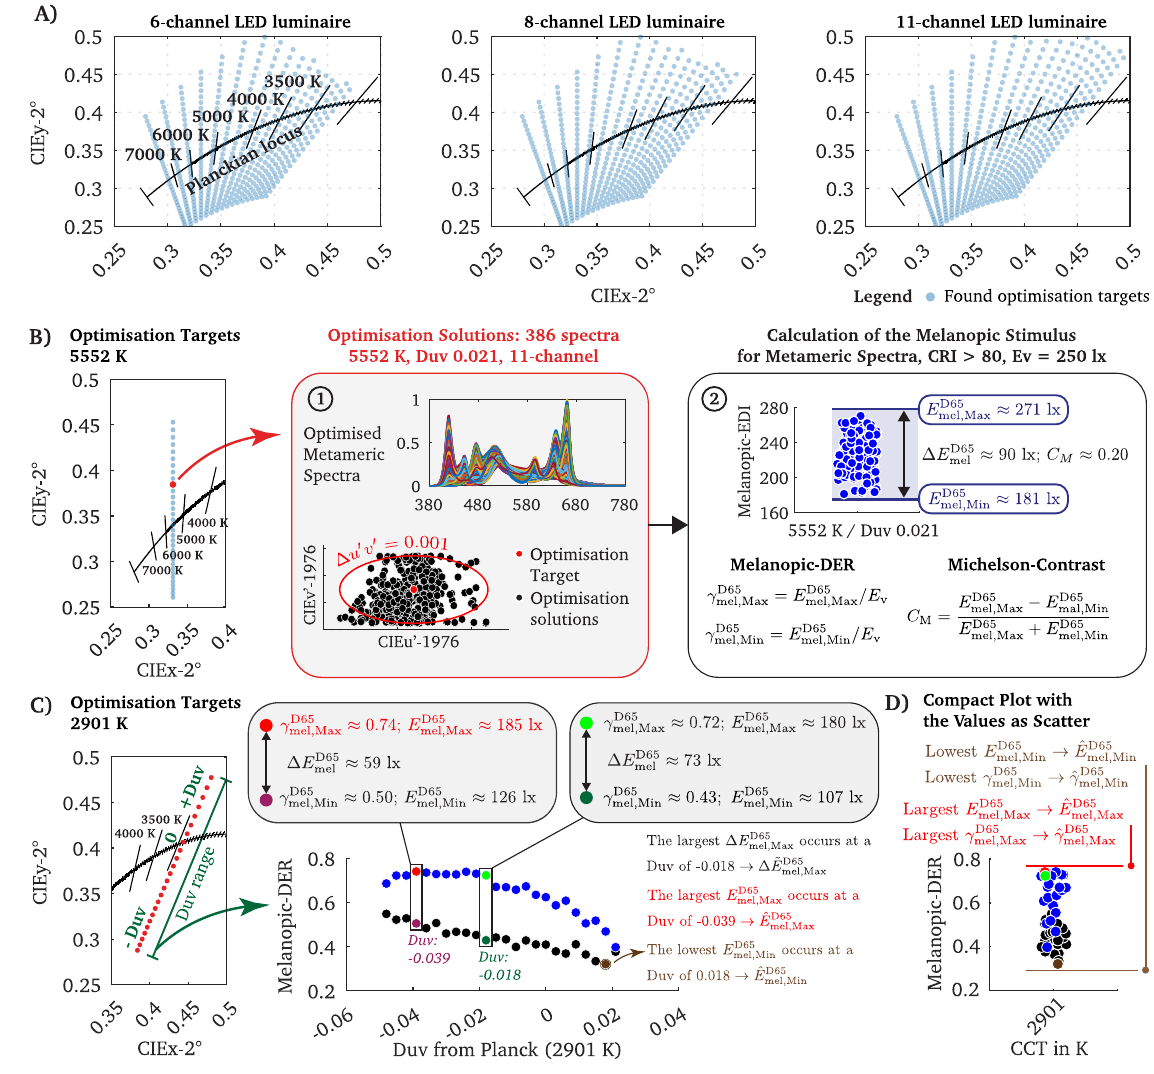
Figure 1. The chromaticity coordinates for which spectra where successfully optimised and strategies of assessing the non-visual quality of the metameric spectra. ( A ) We used a uniform grid of 561 chromaticity coordinates along the Planckian locus (2700 K to 7443 K ± Duv 0 to 0.048 with Duv-steps of 0.003) as optimisation targets for spectral optimisation. Depending on the LED luminaire’s channel configuration, the number of successfully optimised spectra per chromaticity target differs. The 6-channel LED luminaire, for example, was unable to yield spectra for chromaticity targets with higher Duv values at CCTs between 2700 and 3000 K. The blue scatter points in the CIExy-2° colour space highlight the chromaticity coordinates for which metameric spectra were successfully optimised. ( B ) For each of the blue points in the CIExy-2° colour space (left panel), numerous metameric spectra were available. When using a single chromaticity coordinate at 5552 K (Duv of 0.021, red point in the left panel) as an optimisation target for the 11-channel luminaire, 386 spectra were available (see panel 1). We defined spectra whose chromaticity coordinates were inside the tolerance range of (cid:31) u ′ , (cid:31) v ′ ≤ 0.001 (to the optimisation target) as metameric spectra (see panel 1). From the remaining D 65 E D 65 spectra the upper and lower limit of E mel can be classified, representing the melanopic tuning range (cid:31) mel for the single chromaticity coordinate (see panel 2). Each chromaticity coordinate target is characterised with the D 65 D 65 D 65 D 65 E D 65 E D 65 C M . ( C ) respective E mel , γ mel and its melanopic Michelson Contrast mel , Min , mel , Max , (cid:31) mel , Min , γ mel , Max , �γ When considering the chromaticity coordinates for one CCT (left panel), the upper (blue points) and lower D 65 D 65 limit (black points) of the melanopic DER ( γ mel , Min , γ mel , Max ) can be plotted and analysed as a function of the Duv steps, making possible to state which Duv distance to Planck is ideal for spectral optimisation. The largest or lowest melanopic EDI (and respective melanopic DER) values of a CCT (across all Duv values) at a photopic (cid:31) E D 65 (cid:31) E D 65 illuminance of 250 lx will be denoted as mel , Min (brown point), mel , Max (red point). As the melanopic EDI D 65 (cid:31) γ D 65 values correlate with the melanopic DER, these key points can also be expressed with (cid:31) γ mel , Min and mel , Max . The (cid:31) E D 65 (cid:31) γ D 65 largest melanopic tuning range of a CCT will be denoted as (cid:31) mel or for a generalised description as � mel . ( D ) To compare the non-visual metrics across the different CCT steps, we contracted the values for each Duv value to one axis with blue points as the upper limit of the melanopic DER tuning range and black points for the (cid:31) E D 65 D 65 lower limit. The red point states the (cid:31) γ mel , Max value (see panel C) mel , Max and accordingly the